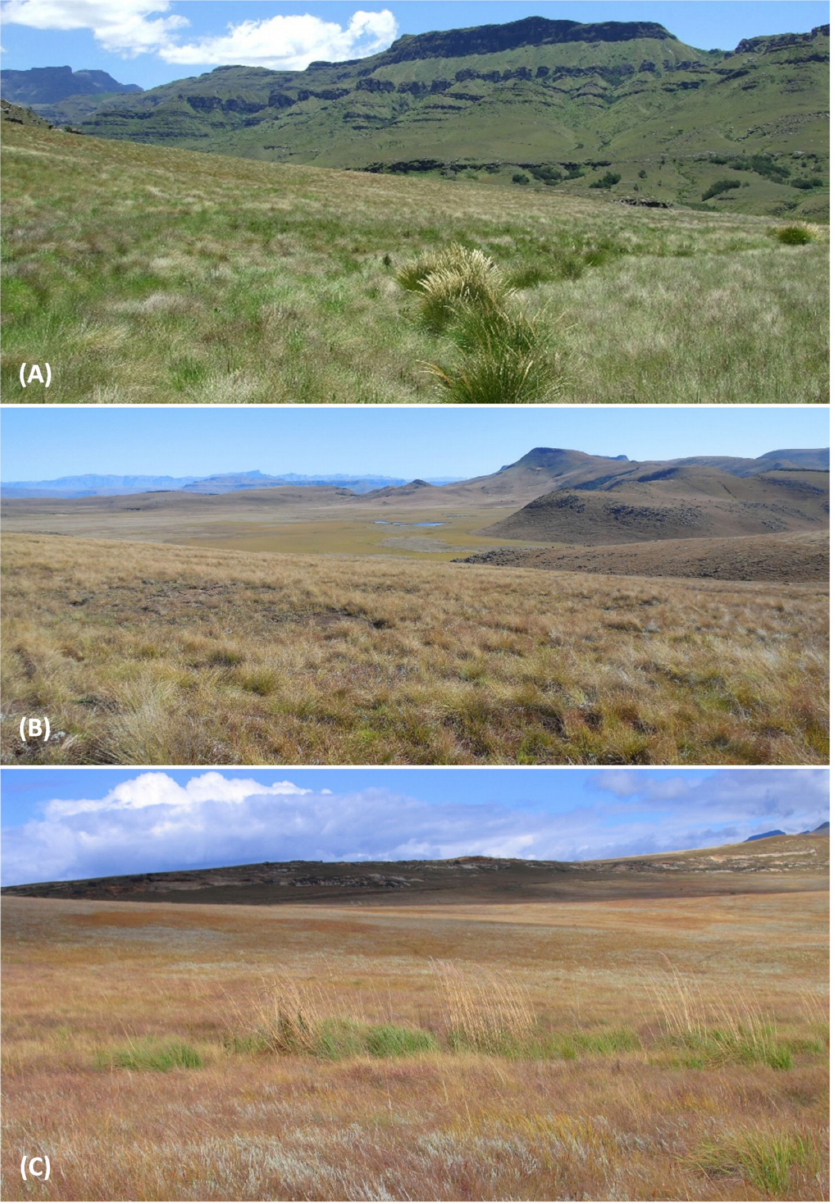
Figure 3. Representative examples of grasslands from the three moist grassland bioregions in the Grassland Biome of South Africa: ( A ) Drakensberg Grassland Bioregion (southern KwaZulu- Natal Drakensberg) (19 November 2012); ( B ) Sub-Escarpment Grassland Bioregion (KwaZulu-Natal Midlands) (14 May 2015); ( C ) Moist Highveld Grassland Bioregion (eastern Free State) (6 May 2010). All photos by C.